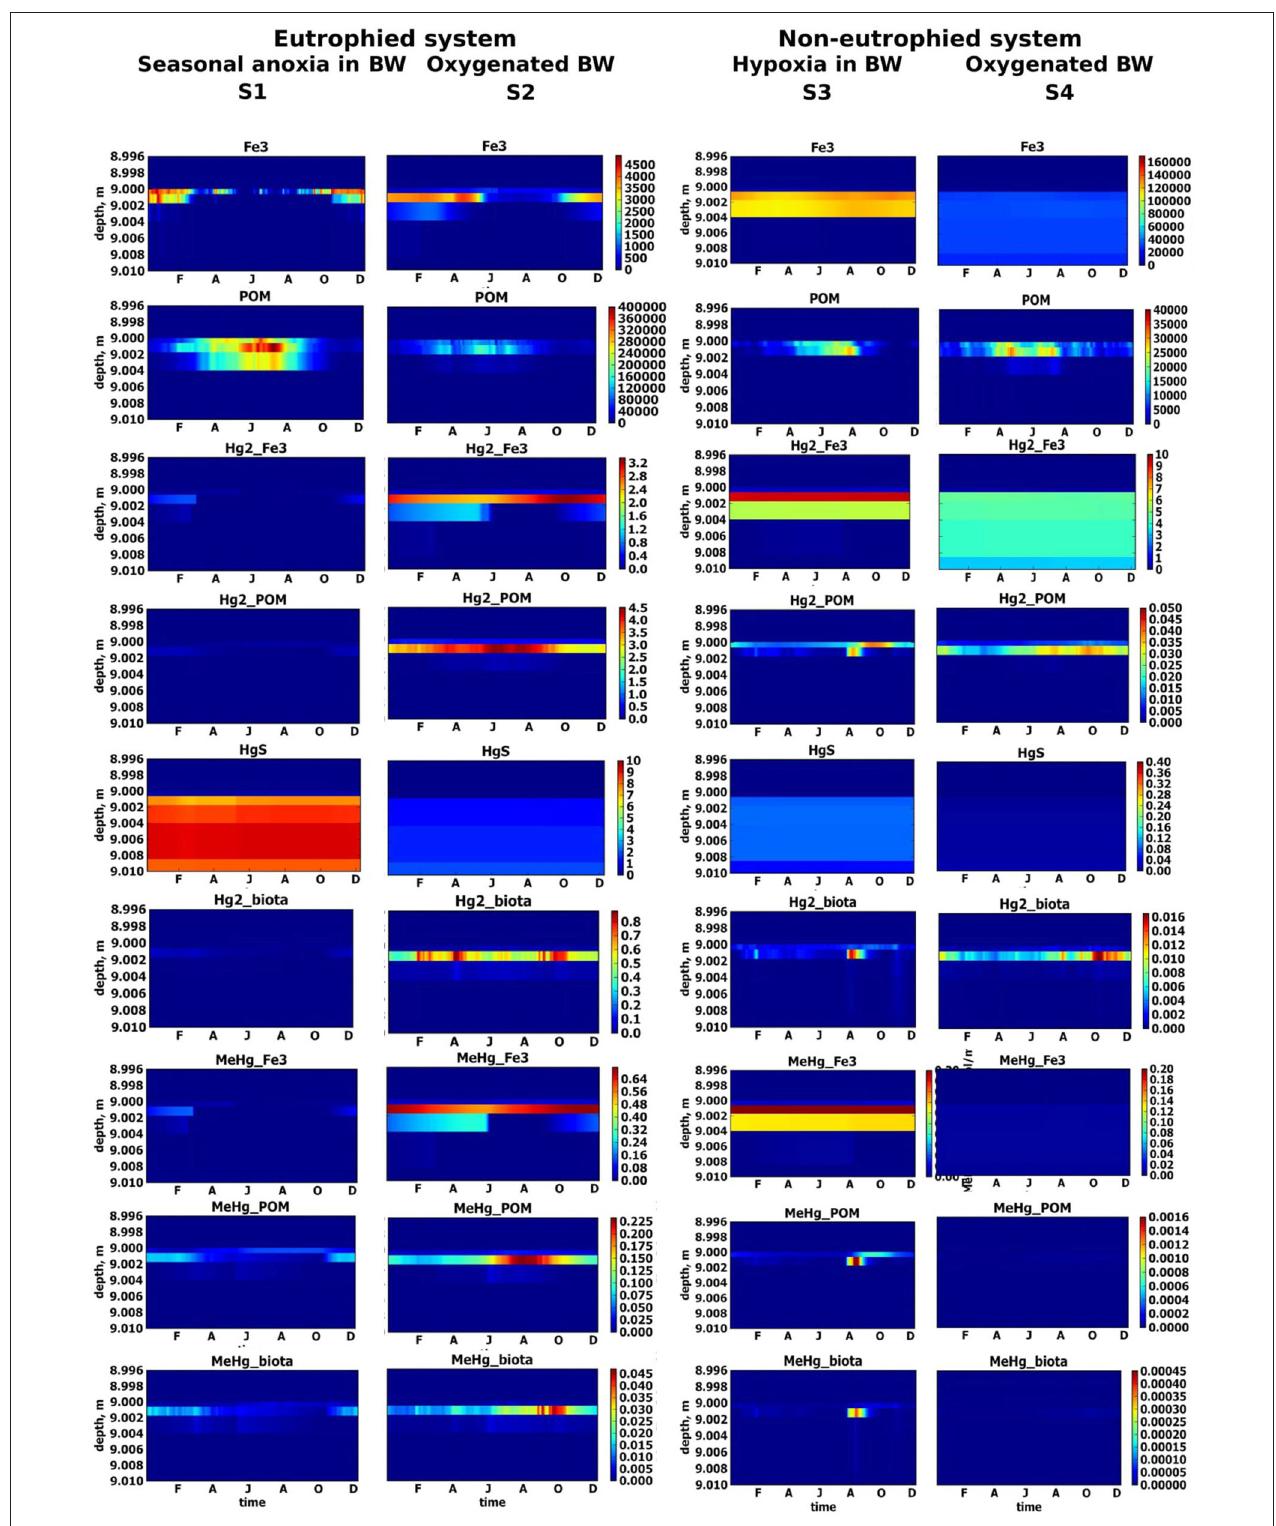
FIGURE 5 | Simulated seasonal dynamic of solid variables ( µ M) in upper sediment layer for different scenarios, S1–S4. Sediment-water interface is positioned at 9m depth.